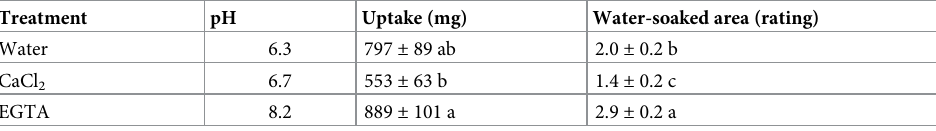
Table 3. The effect of CaCl 2 (10 mM) and the chelating agent EGTA (10 mM) on water soaking of ‘Clery’ straw- berries. The fruit was incubated for 4 h.